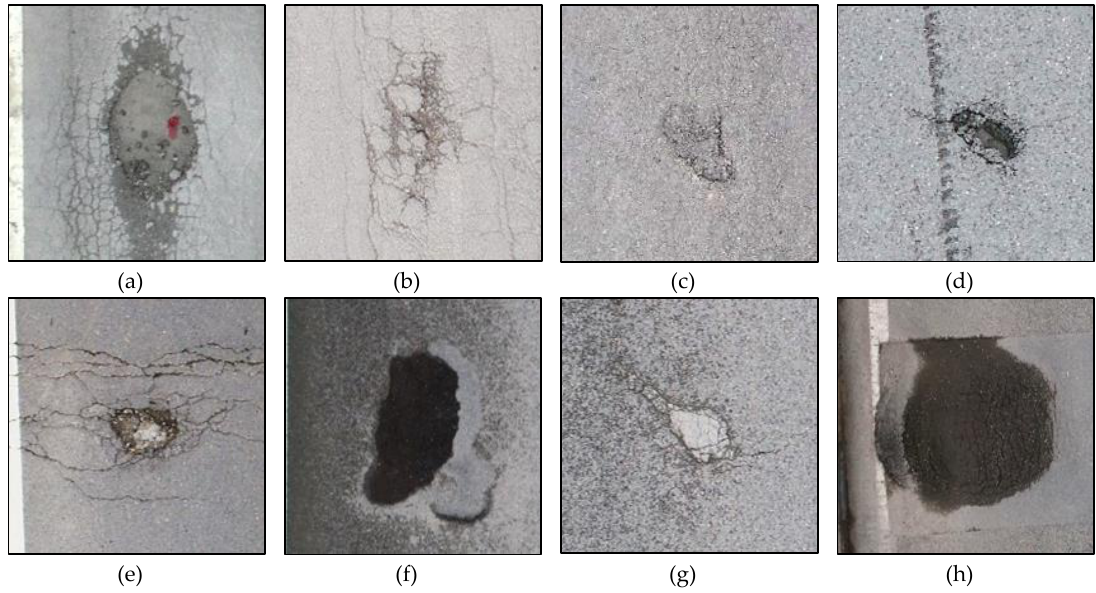
Figure 17. Distress conditions: ( a – h ) target distresses of roads 1–8, among which ( a , b , d , e ) are road cavities and ( c , f , g , h ) are road bulges.